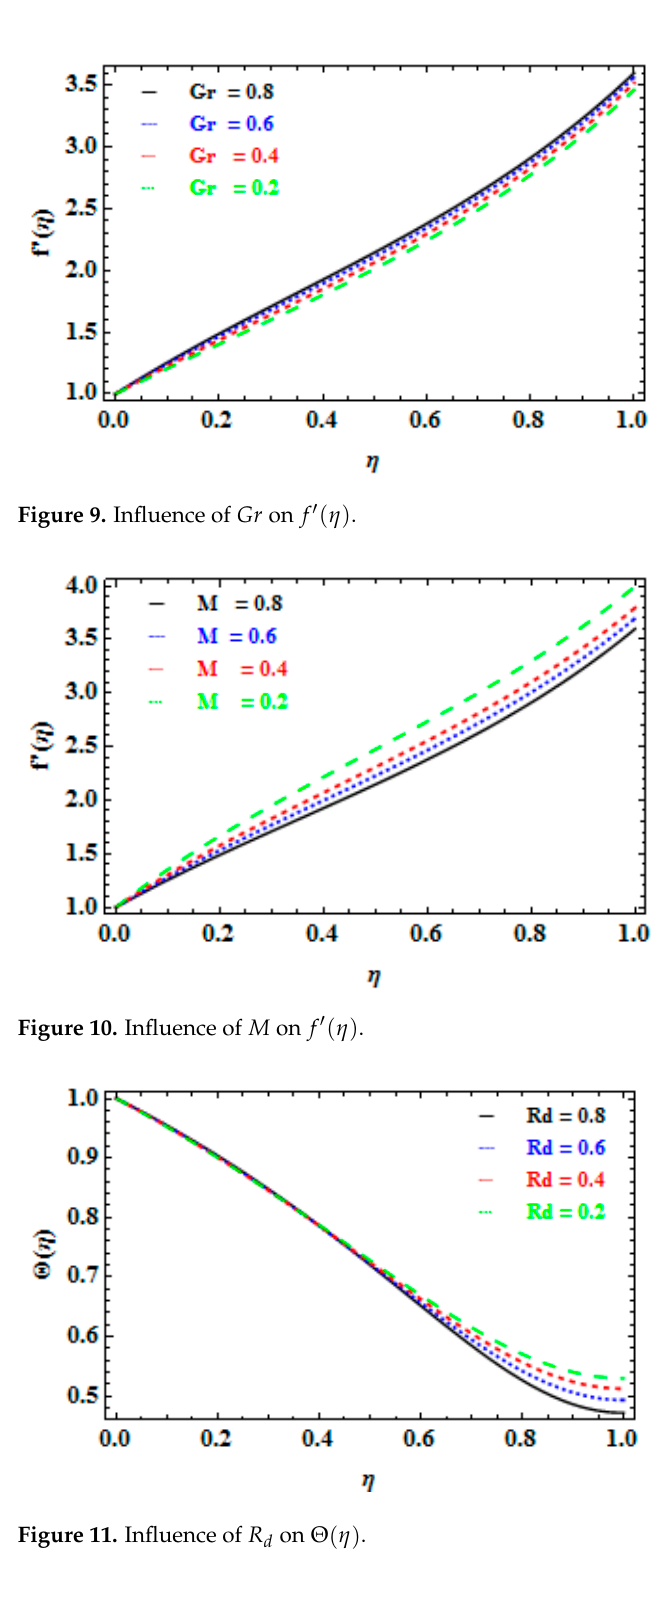
Figure 11. Influence of R d on Θ ( η )